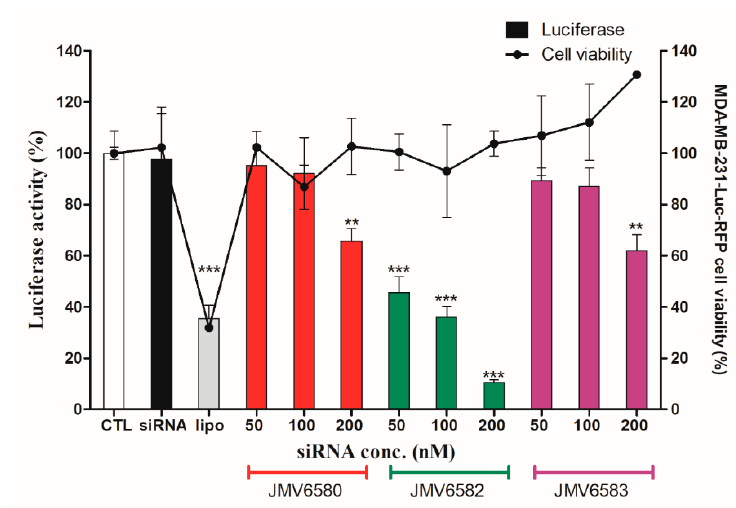
Figure 5. Luciferase activity assay showing the transfection of a 21-mer small interfering RNAs (siRNAs) targeting the expression of luciferase inside MDA-MB-231-Luc-RFP cells. The experiments were carried out with increasing amounts of siLuc (from 50 to 200 nM) complexed with the stapled peptides. The corresponding concentrations of the peptides are from 1.05 µ M to 4.2 µ M for JMV6580, from 1.4 µ M to 5.6 µ M for JMV6583 and from 5.25 µ M to 21 µ M for JMV6582. For lipofectamine transfection, the siRNA concentration used is 50 nM. In parallel, cell viability was measured for each condition. Results are expressed as mean ± standard deviation (n = 3). Statistically different, the level of significance was defined ** p < 0.01, and *** p < 0.001.